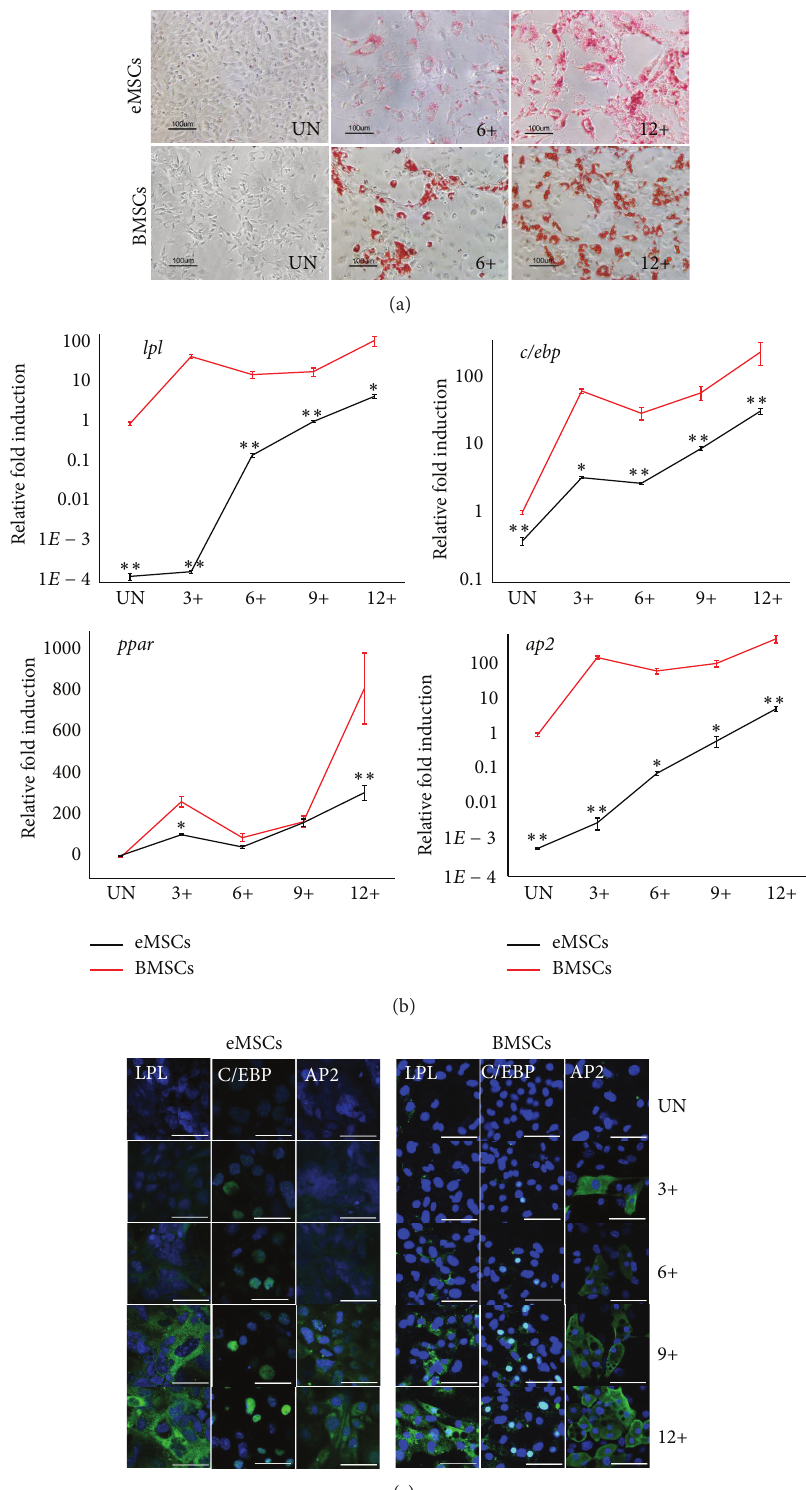
Figure 6: Adipogenic differentiation potential of eMSCs and BMSCs. (a) Lipid-containing adipocytes detected by Oil Red O staining after 12d of culture in adipogenic medium. Samples from uninduced cells (UN) and induction cells (days +). (b) Gene expression profiles related to adipogenic differentiation in induced and uninduced (UN) cells. RNA samples from uninduced cells and induction cells (days +). Values are the means ± SD from 3 independent experiments. ∗ 𝑃 < 0.05 , ∗∗ 𝑃 < 0.001 . (c) Immunofluorescent staining for AP2, C/EBP, and LPL, antibody staining (green), with DAPI nuclear staining (blue). Samples from uninduced cells (UN) and induction cells (days +). Bars = 50 𝜇